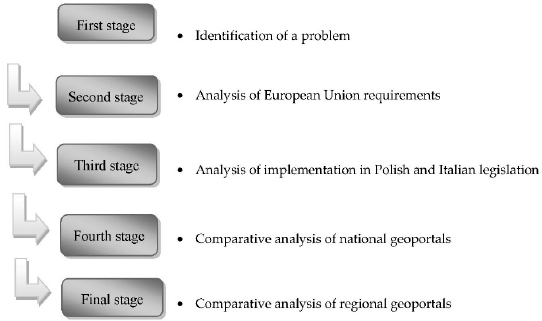
Figure 1. Procedure of conducted research Source: own study.